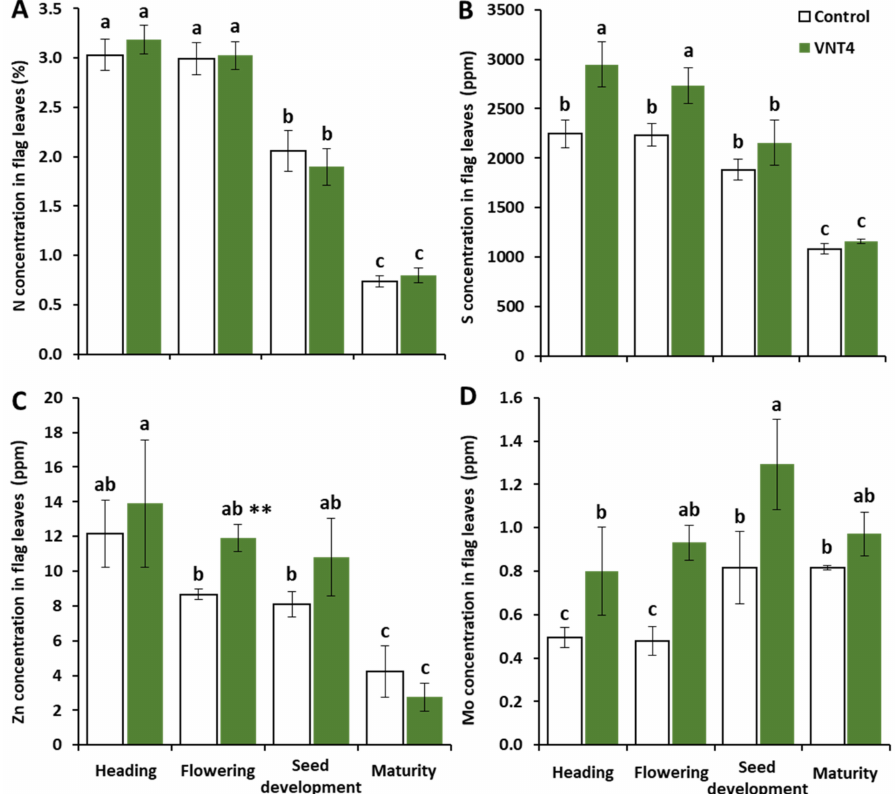
Figure 4. Influence of VNT4 on element concentration in flag leaves of winter wheat at site 4 in 2020. ( A ) N concentration, ( B ) S concentration, ( C ) Zn concentration and ( D ) Mo concentration in flag leaves during the crop cycle. N was provided at the tillering, stem elongation and flag leaf stages. 5 L ha − 1 of VNT4 formulation (see Table 1 for more details) were mixed with UAN before each N application, leading to a global application of 15 L ha − 1 . Bars indicate means ± SE, different letters denote significant differences according to Fisher’s test ( p < 0.05, n = 4) and stars denote significant differences between control and VNT4 according to a pairwise comparison (Fisher’s test, **; p < 0.01, n =